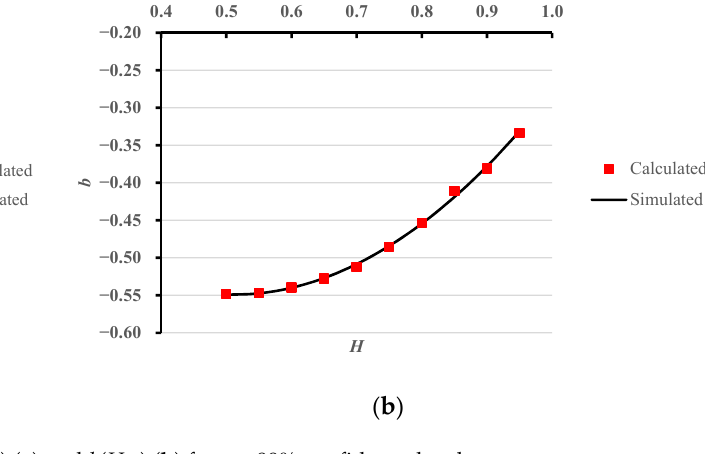
Figure 4. Functions a ( H , q ) ( a ) and b ( H , q ) ( b ) for q = 99% confidence level.